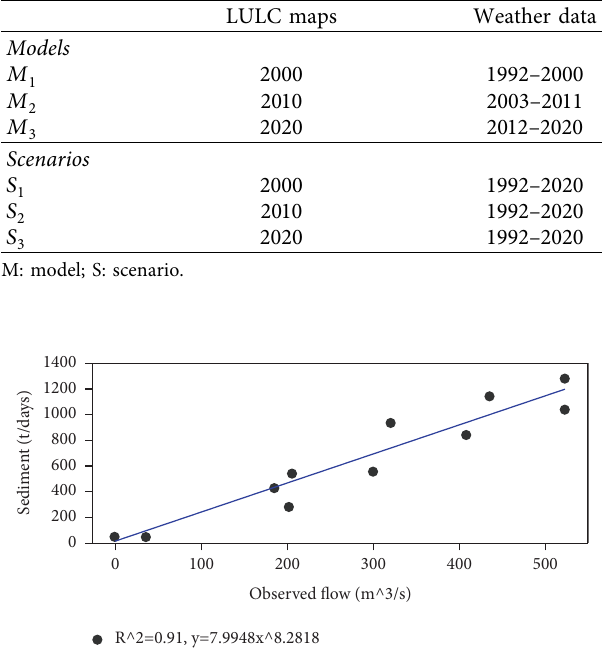
Figure 5: Sediment rating curve for the